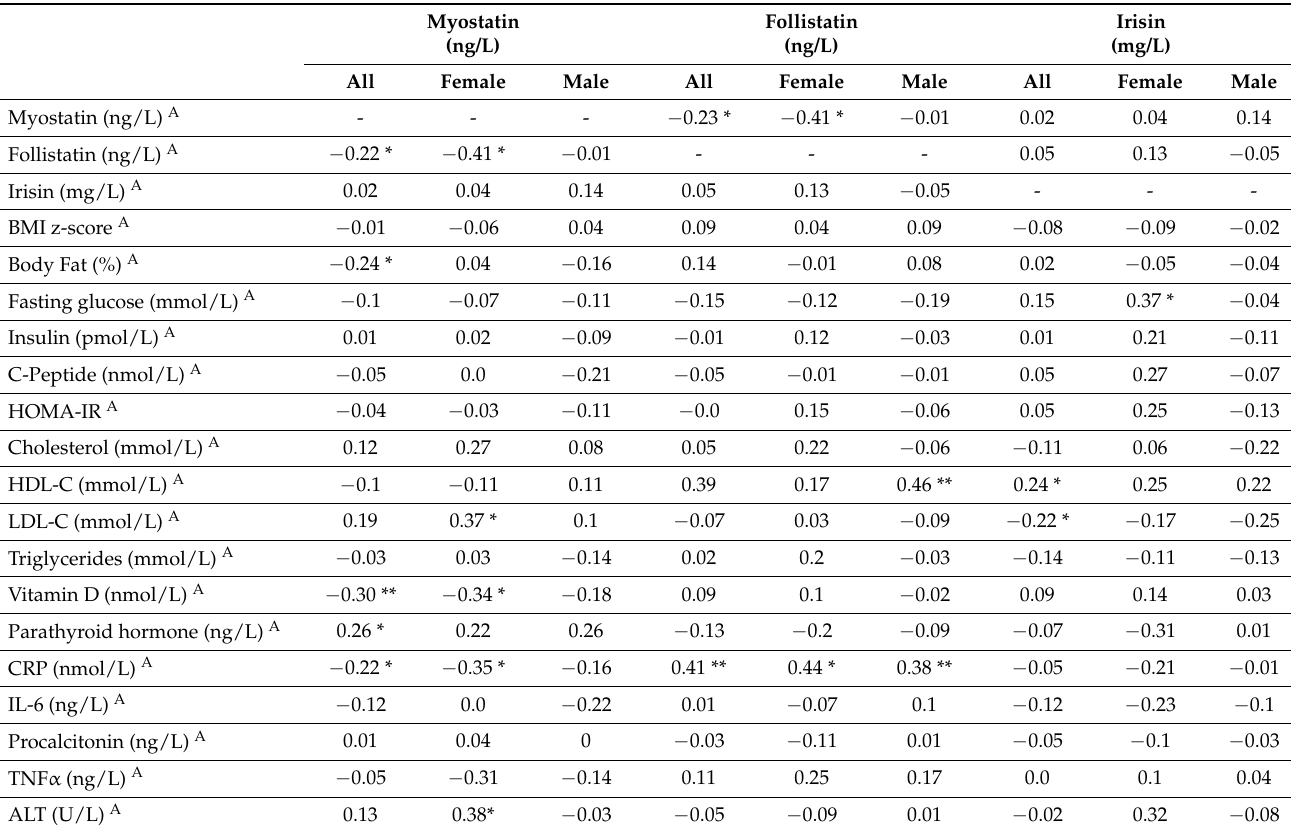
Table 3. Correlation coefficients of myostatin, follistatin, and irisin with various parameters adjusted for age and Tanner stage.